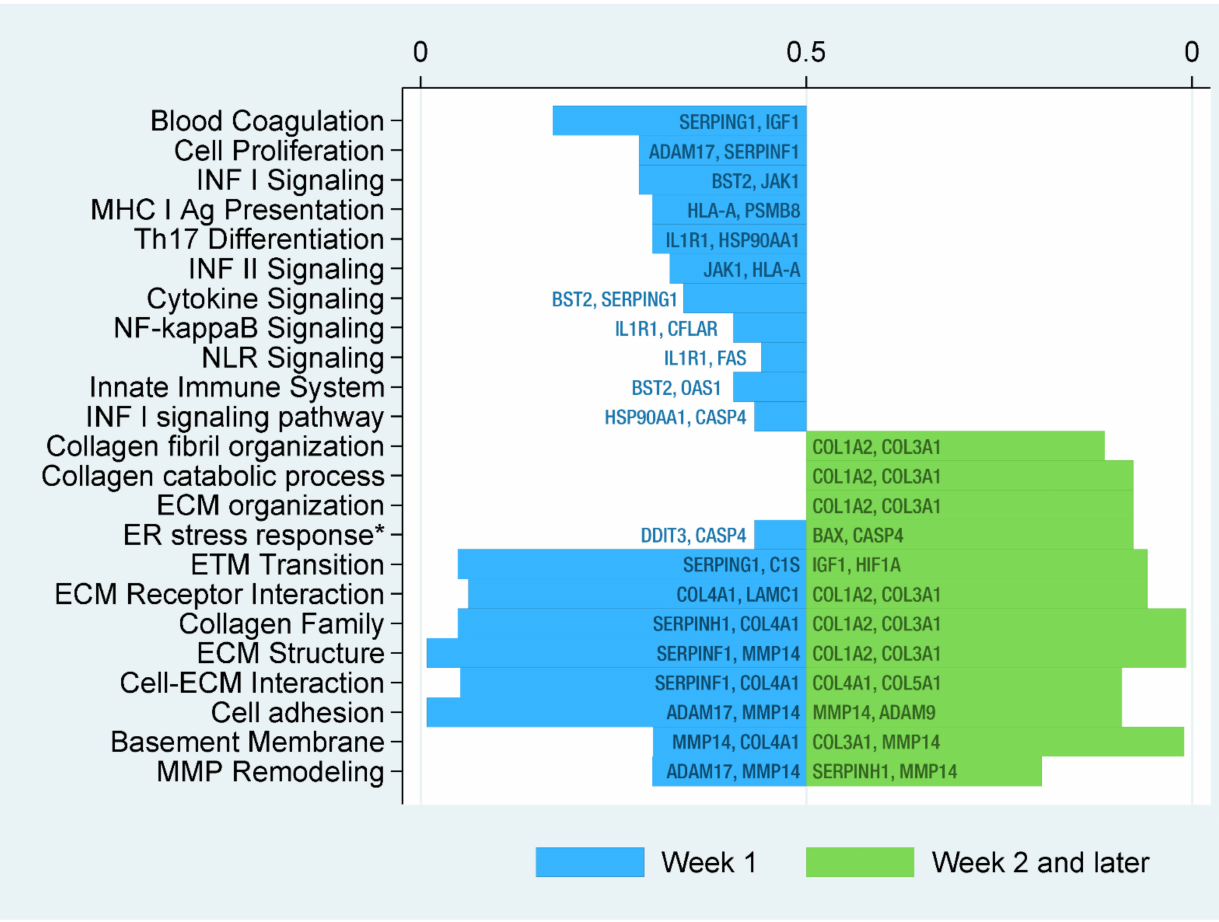
Figure 2. Significantly regulated biological pathways over time and corresponding fdr